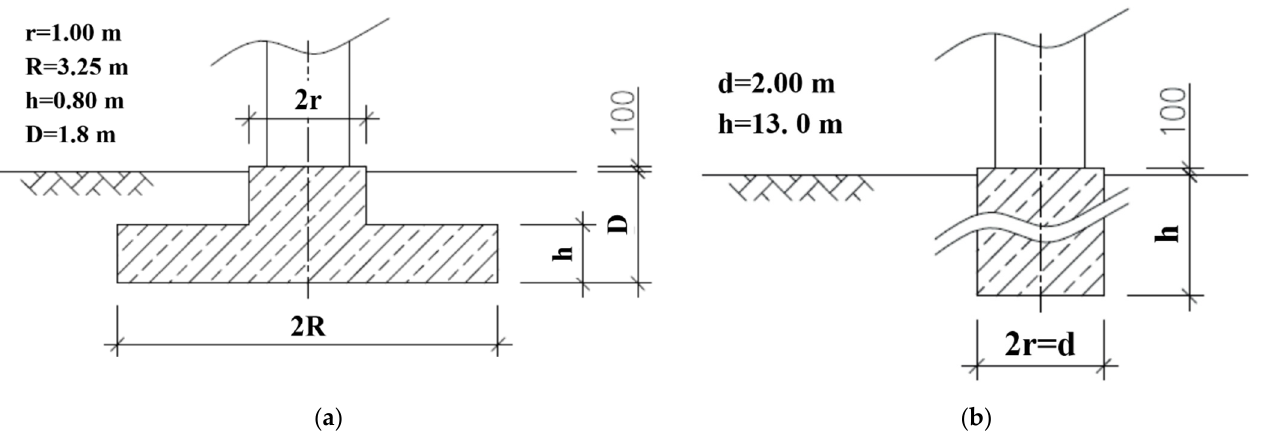
Figure 8. The geometry of the wind turbine foundation of: ( a ) a circular footing; ( b ) a monopile [77,110].